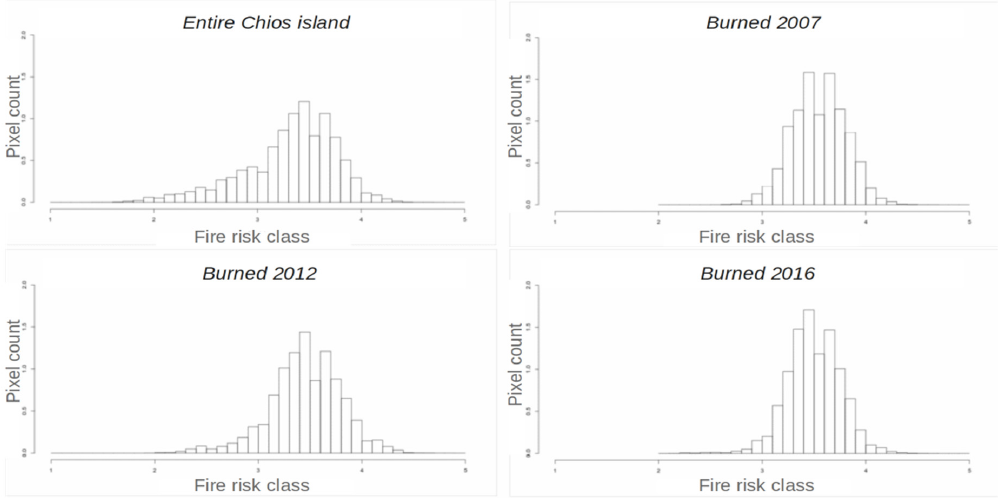
Figure 9. Histograms of the fire risk map for the entire island (upper left) and the pixels contributing to the area burned from the fires in 2007 (upper right), 2012 (lower left) and 2016 (lower right). The areas burned by the 2007, 2012 and 2016 fires generally have southern and western aspects that receive a relatively high solar illumination (Figure 9). A clear correlation between the number of fire outbreaks and the proximity to a road was also observed. In addition, there is good agreement with the elevation parameter. Chios is generally a mountainous island, and the flat areas are primarily found in the southern and eastern parts, while the highest peaks are in the Northern part of the island (Pelineo Mt, St, Ilias top reaching 1297 m).